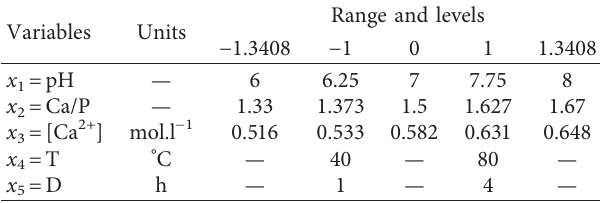
Table 1: Experimental range and level of independent variables.